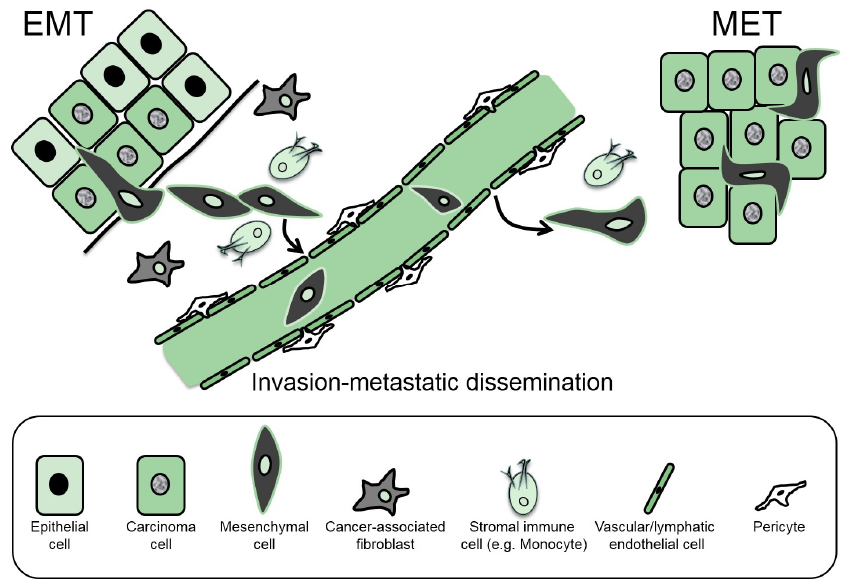
Figure 1. Schematic representation of EMT (epithelial–mesenchymal transition) and MET (mesenchymal–epithelial transition) in the context of carcinoma progression. Hyperplastic epithelial cells (light green cytoplasm) are shown aligned along their basement membrane (thick black line). Carcinoma cells develop in this primary tumor (deep green cytoplasm) and some undergo EMT, forming mesenchymal cells (black cytoplasm) that degrade the basement membrane and invade the local microenvironment. EMT and invasiveness are enhanced by auxiliary paracrine signals from stromal fibroblasts and immune cells, thus facilitating the movement of mesenchymal cells to the blood or lymphatic vessels where they can intravasate. Upon successful survival in the lymphatic or vascular circulation, some mesenchymal cells extravasate and initiate micrometastases consisting of mesenchymal cells and a bulk of carcinoma cells (deep green cytoplasm) that are generated via MET. The cell types of the schematic are explained below the picture.